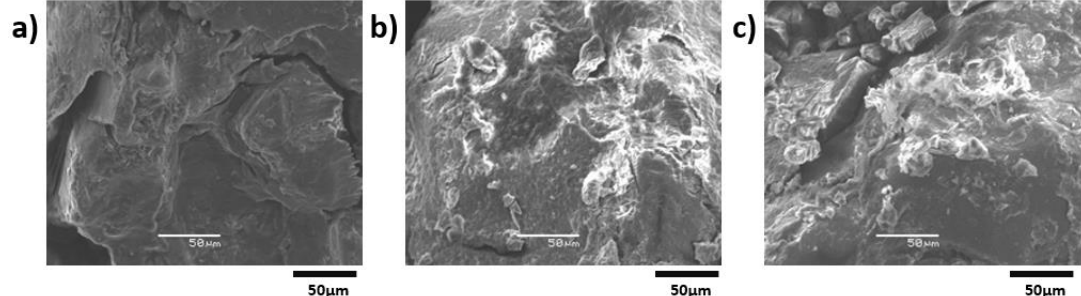
Figure 13. Demonstration of the remolded Pisha sandstone solidified with W-OH type polyurethane. ( a ) The original Pisha sandstone; ( b ) R-P-1 type remolded Pisha sandstone (4% W-OH); ( c ) R-P-5 type remolded Pisha sandstone (8% W-OH).